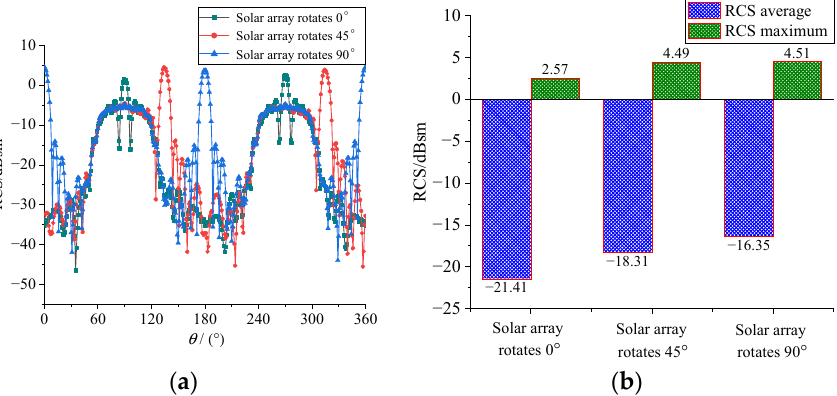
Figure 15. Comparison of RCS under different rotation angles. ( a ) RCS characteristic distribution; ( b ) RCS mean and maximum.